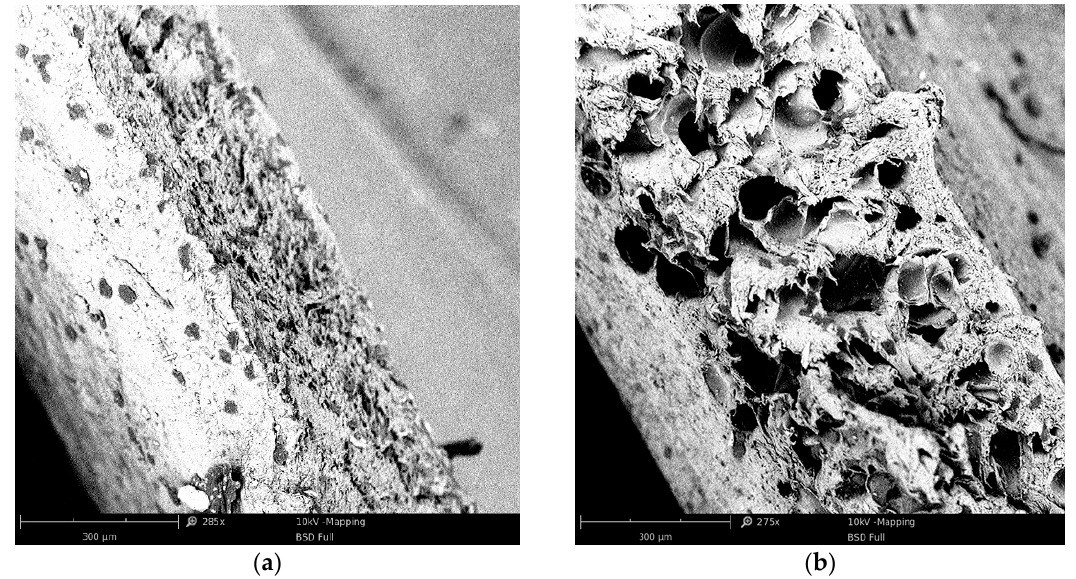
Figure 8. Scanning electron micrographs of the PVC double coatings: ( a ) PVC + 0.2% BA; ( b ) PVC + 0.6% BA.